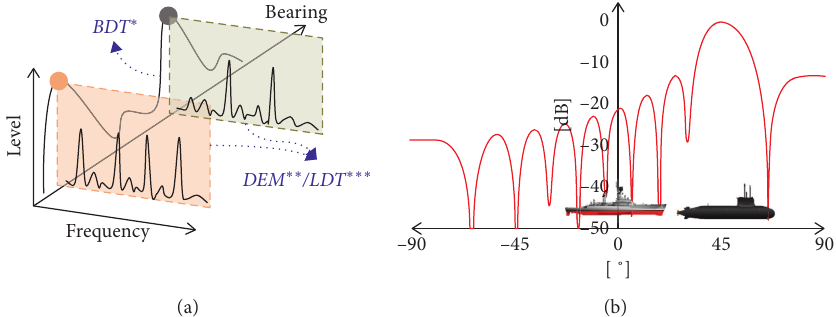
Figure 5: Sonar simulator descriptions: (a) analysis of the radiated noise; (b) sonar operation based on radiated noise.